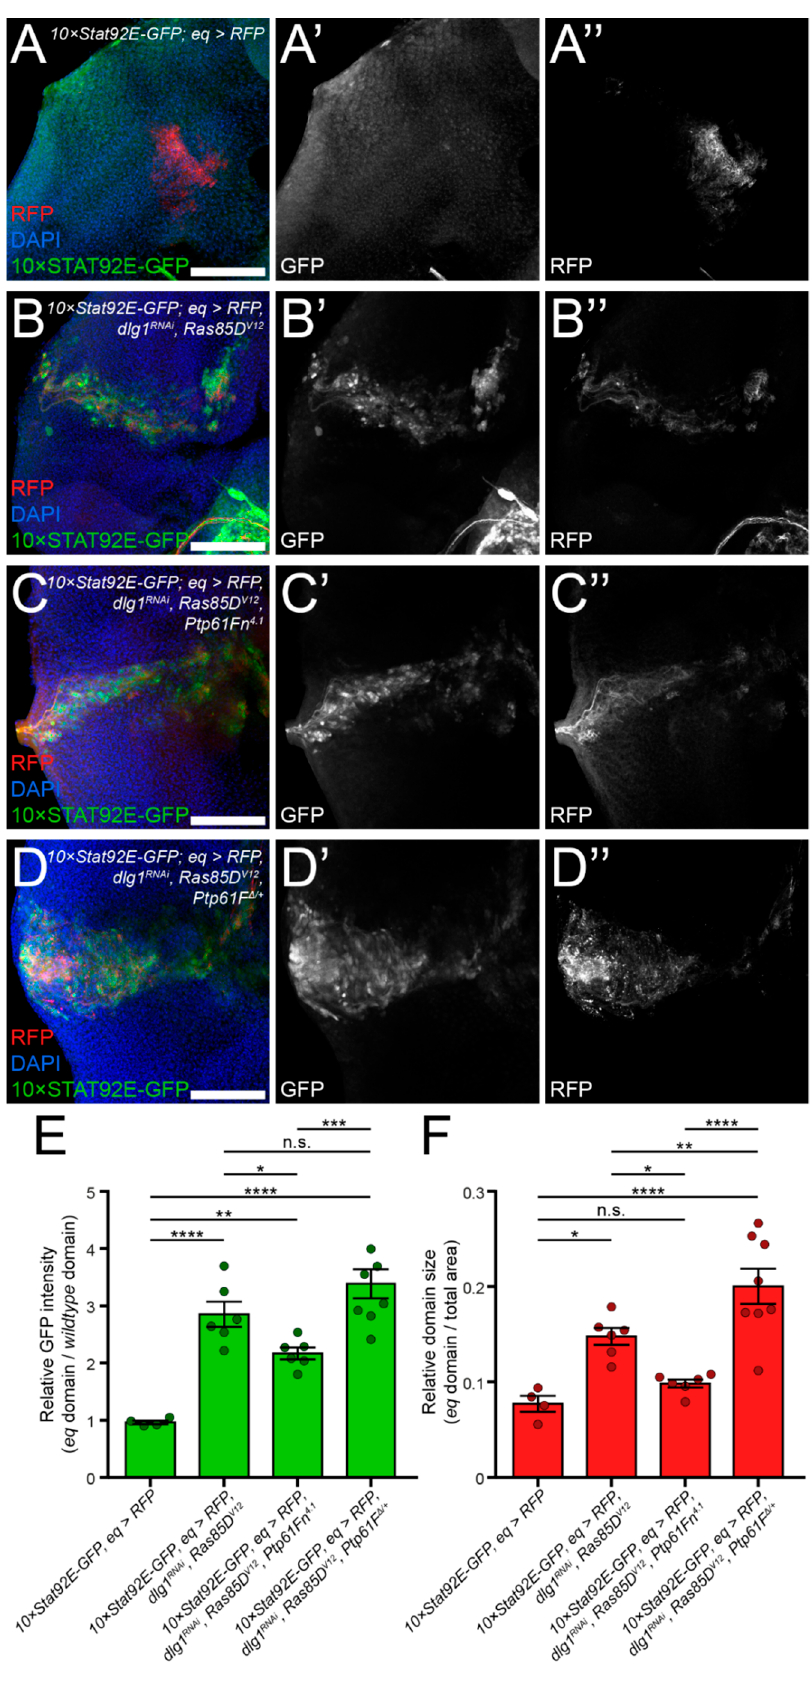
Figure 7. PTP61F represses JAK–STAT signalling pathway activity in activated RAS85D-driven po- larity-impaired tumorigenic tissue. ( A – D ) Confocal images of L3 eye imaginal disc epithelial tissue